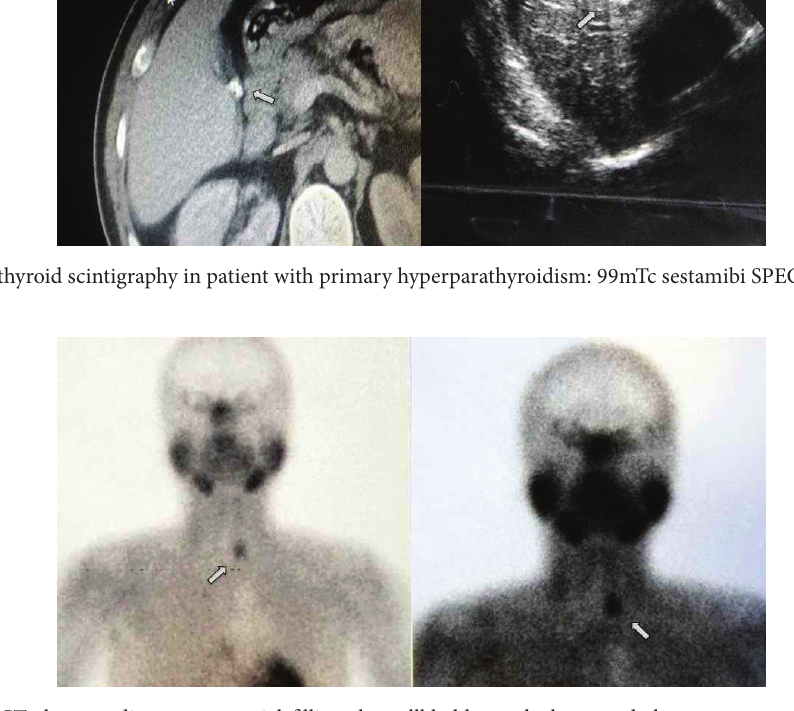
Figure 2: Abdominal CT shows radiopaque material filling the gallbladder and ultrasound shows an acoustic shadow consistent with gallstones (white